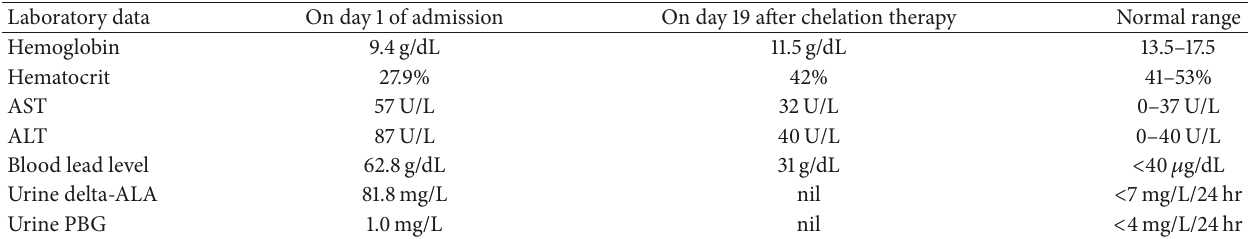
Table 1: The abnormal laboratory results obtained on admission and discharge of patient.